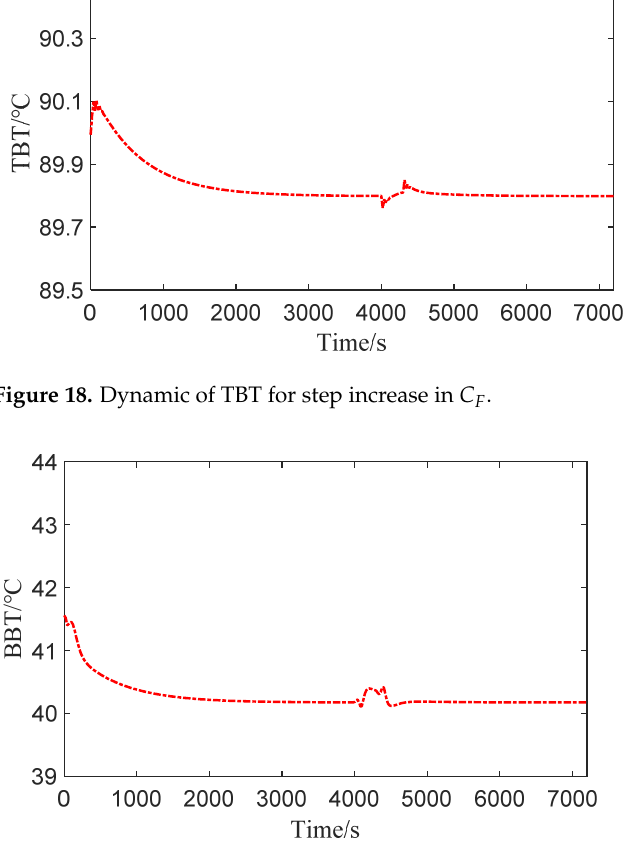
Figure 19. Dynamic of BBT for step increase in C F